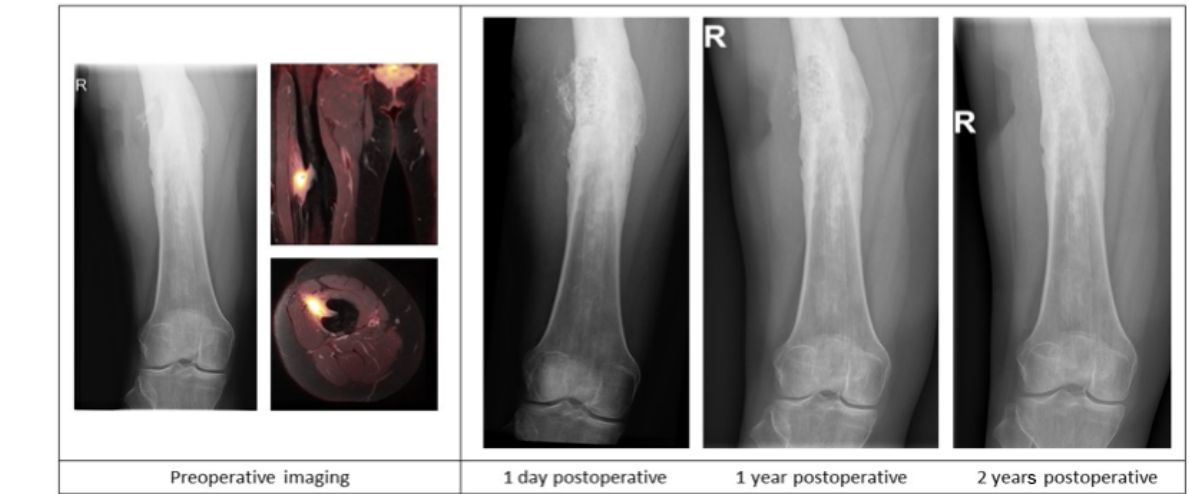
Figure 2. Case description of a 50-year-old female at our outpatient clinic with a painful upper leg and a draining fistula 20 years after an open femoral fracture. Preoperative X-ray and PET-MR imaging showing a chronic intramedullary osteomyelitis of the femur with a fistula and a sequester. Postoperative X-ray imaging after one-stage debridement surgery and implantation of S53P5 bioactive glass show bone defect filling and partial degradation of the S53P5 bioactive glass particles is shown.